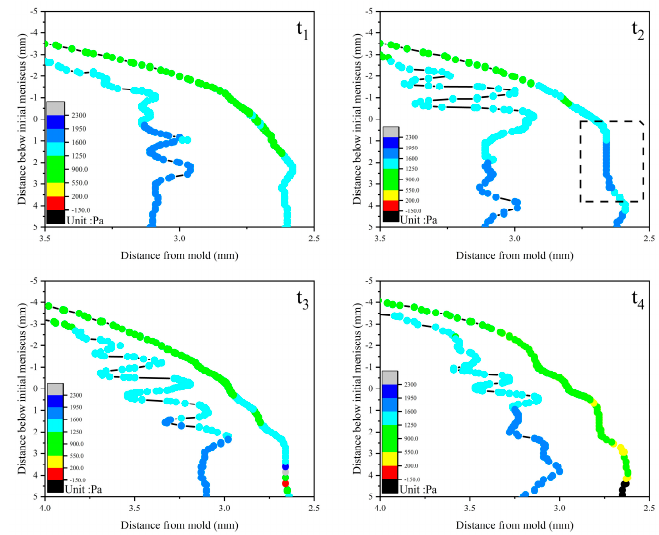
Figure 8. Evolution of shell profile during one cycle.